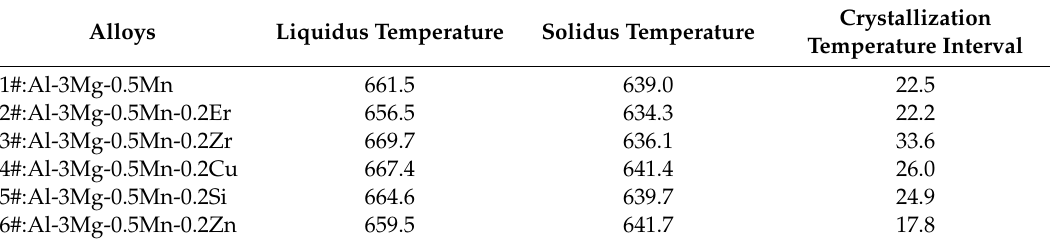
Table 3. DSC curve analysis results of as-cast alloys / ◦